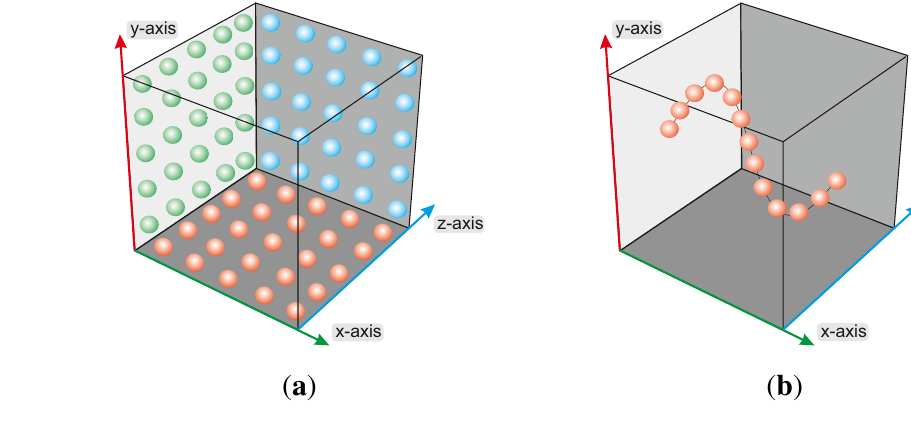
Figure 3. Visualization of the Basic Test Cases: ( a ) Positions in the xy-, xz- and yz-Plane and ( b ) Positions on a Sinus Function Within the